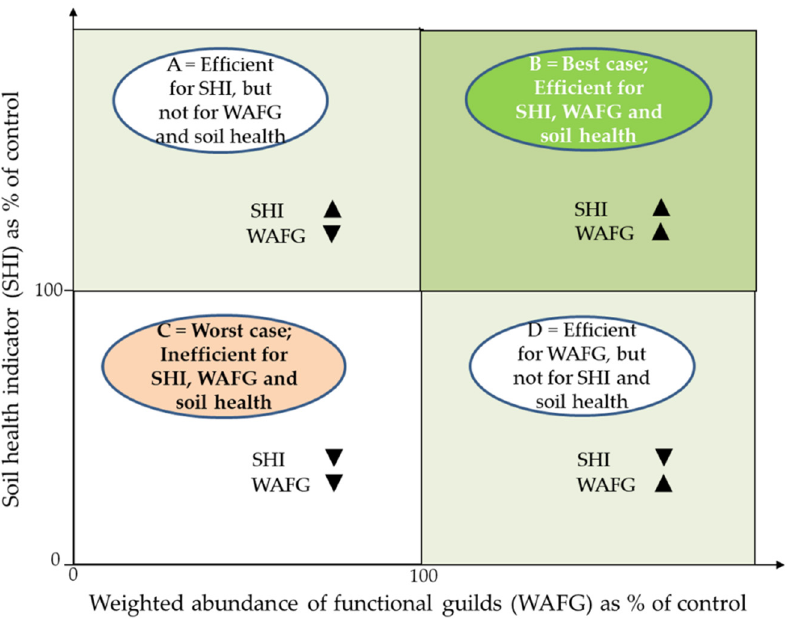
Figure 2. A conceptual illustration of the Integrated Production Efficiency (IPE) model that uses the relationship between changes in Weighted abundance of functional guilds (WAFG, x -axis) of nematodes and soil health indicators (SHI, y -axis) expressed as a percent of control to identify outcomes from best-to-worst cases for integrated efficiency for WAFG, SHI, and soil health and overall sustainability of the outcomes. Increases ( ▲ ) and decreases ( ▼ ) in the SHI and WAFG are indicated. Data points that fall above the controls (100%) will show an increase/improvement in tested SHIs (A and B) and WAFG (B and D). Data points in Quadrant B where a desired SHI and WAFG increase would be best-case scenario for soil health and sustainability of the outcome. Data points in Quadrant C where SHI and WAFG decrease would be worst-case scenario for soil health, environmental and economic outcomes and unsustainable. Data points in Quadrants A and D provide a choice of improving WAFG and SHI, respectively, to achieve soil health.